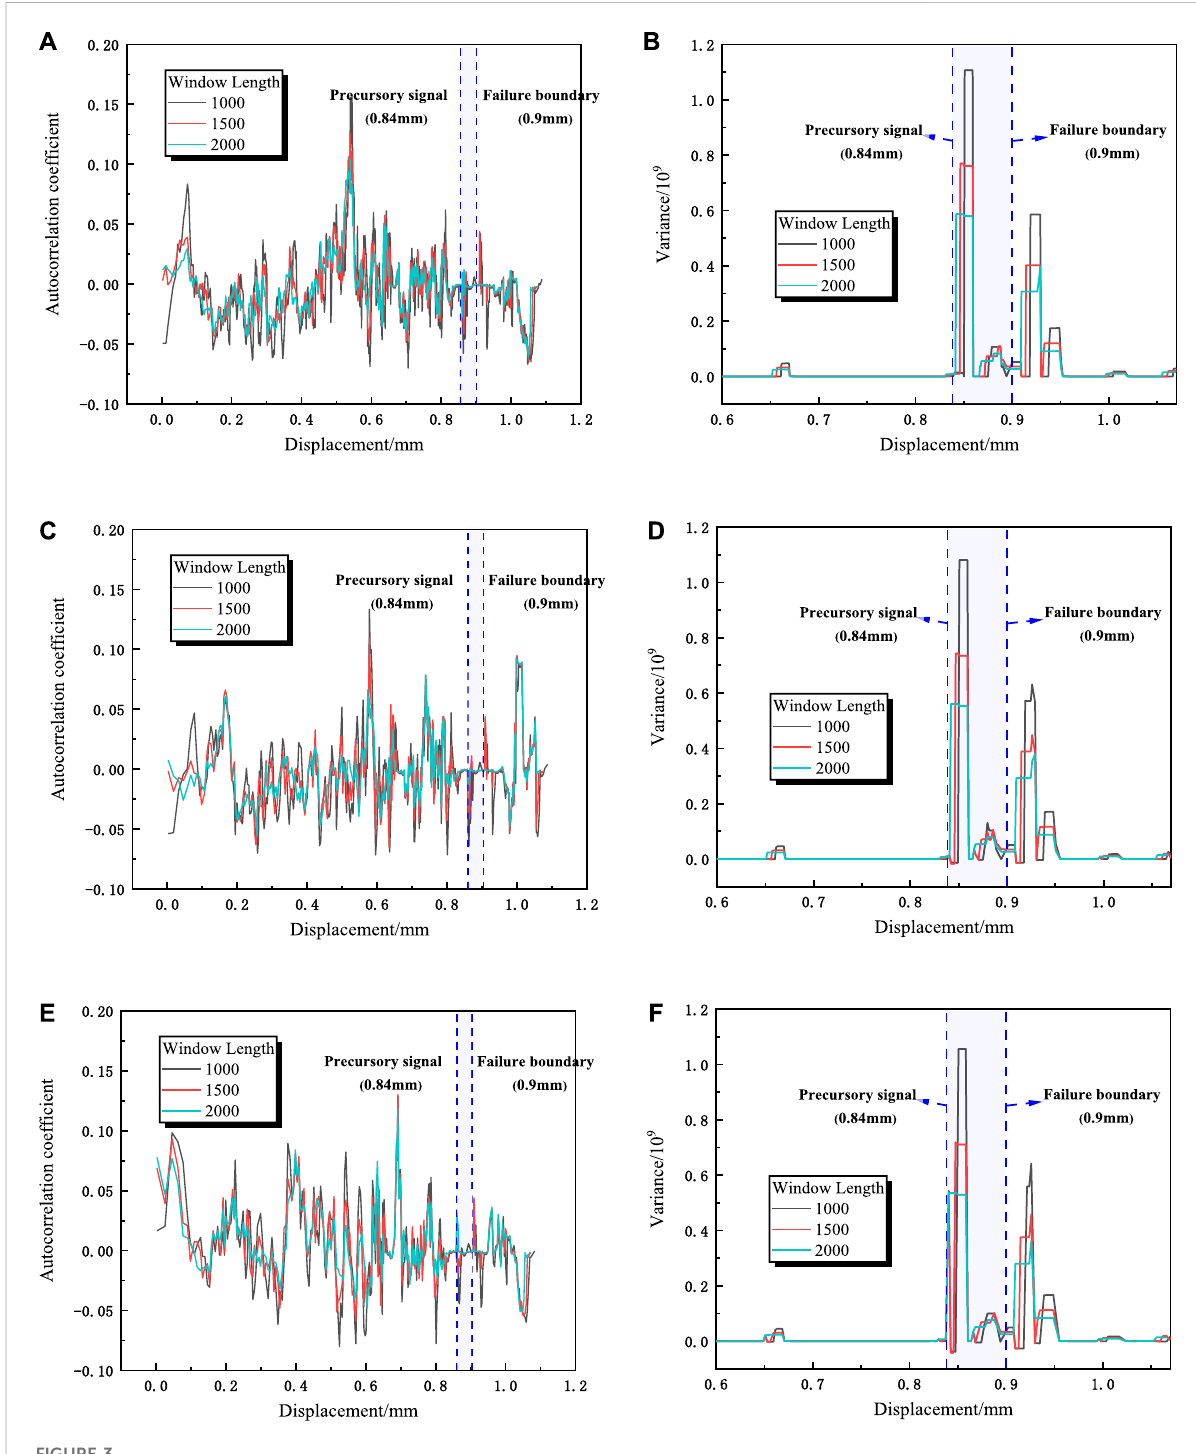
Theself-correlationcoef fi cientandvariancevariationcharacteristicsofdifferentwindowlengths (A,B) :lagsteplength100, (C,D) :lagsteplength 200, (E,F) :lag step length